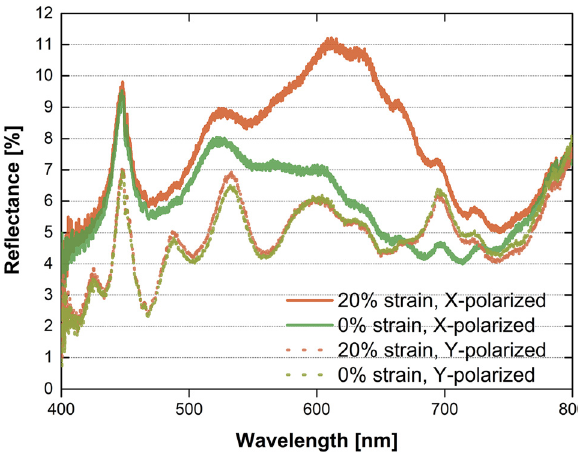
Figure 6: Optical reflectance of Ag nanodots fabricated by soft NIL by using the 300S PDMS nanohole mold stretched with various strains, in X- or Y-polarized